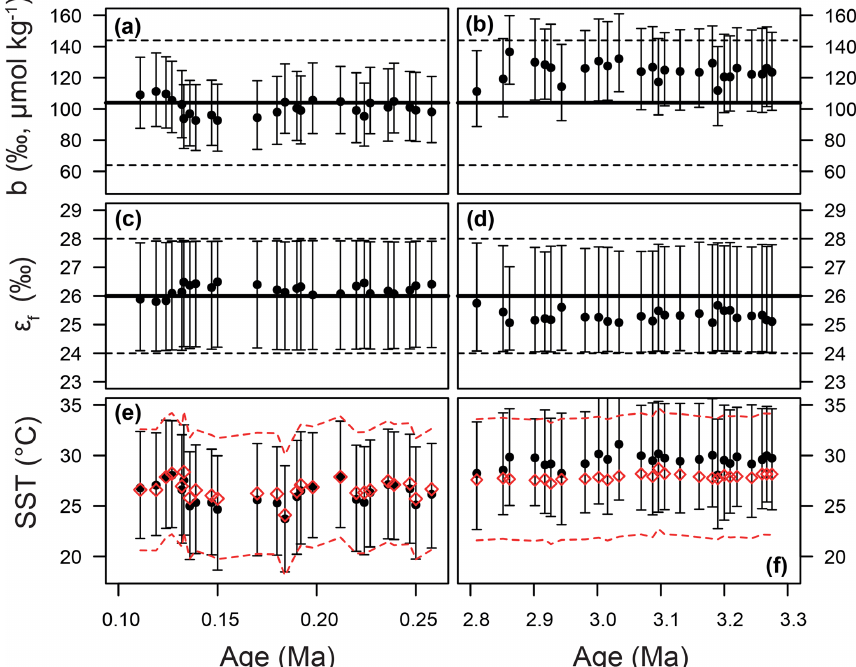
Figure 9. Time series of priors and posteriors for the b term (a, b) , ε f (c, d) , and SST (e, f) . The Pleistocene is shown on the panels on the left and the Pliocene on the right. In panels (a–d) , the mean of the prior distribution is shown as a thick black line. For the b term, 95% of the input distribution is shown as a dotted line; for ε, f the total range is shown. See Fig. 7 for examples of these distributions as probability functions. For SST (e, f) , the prior is shown as red diamonds, with 95% of the distribution shown as the dashed lines. In all panels, the medians of the posterior distributions are shown as circles, with error bars encompassing 95% of the